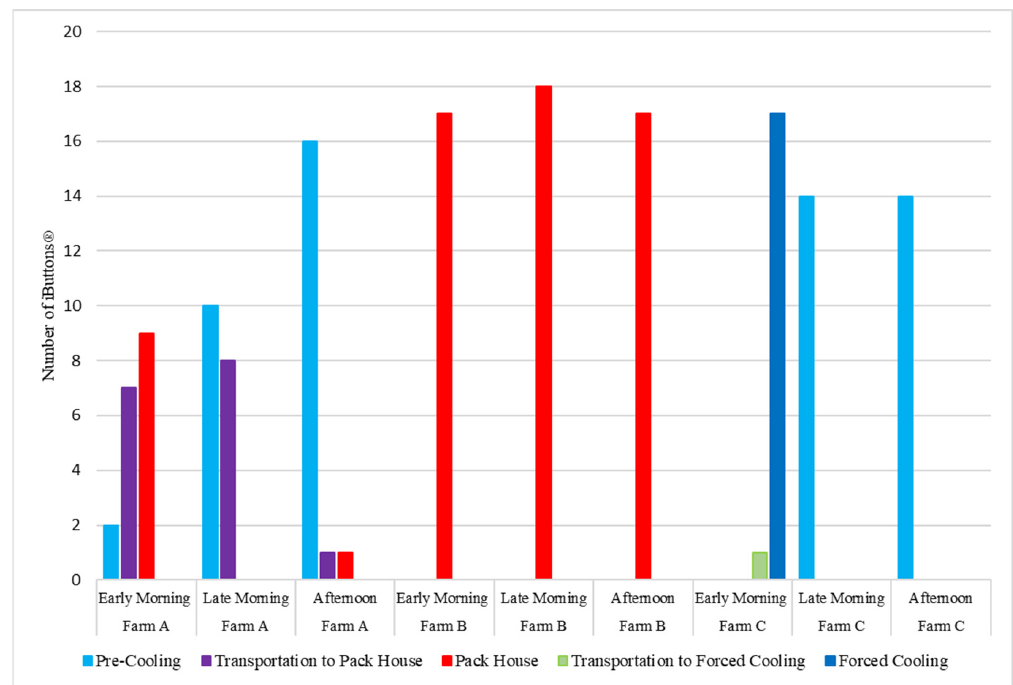
Figure 7. Time in minutes to reach PT = 6 °C on Gauteng farms. Source: [13].